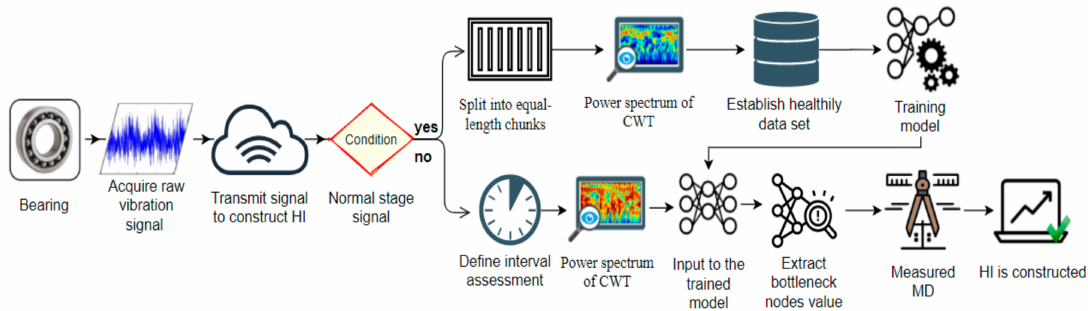
Figure 1. Proposed methodology for the construction of a bearing health indicator ( HI